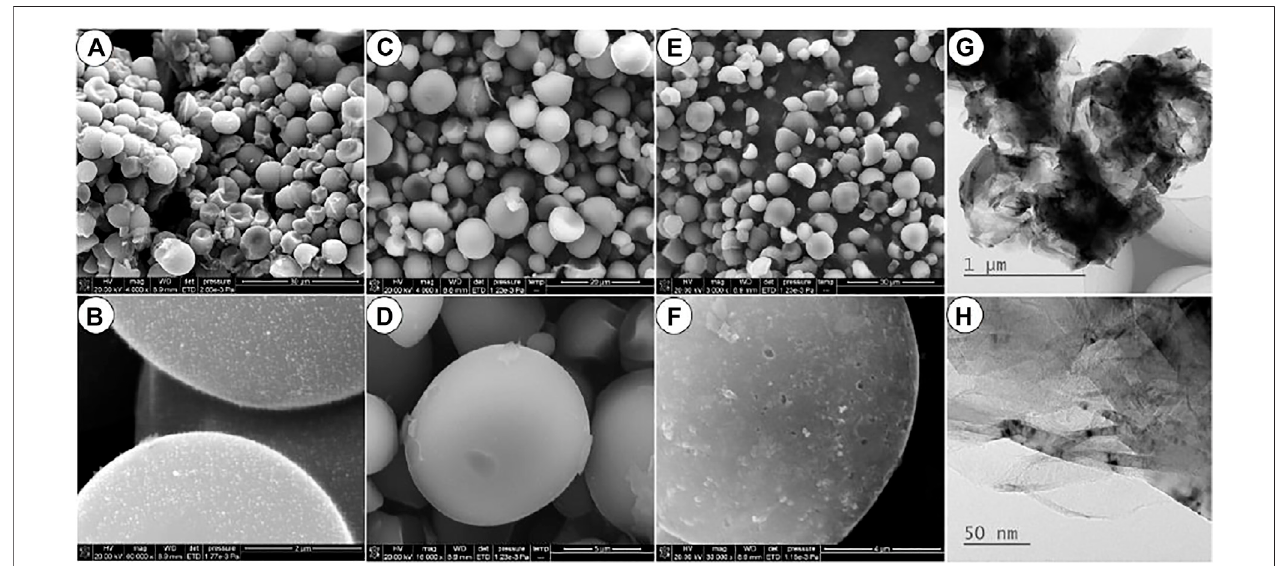
Frontiers in Chemistry |